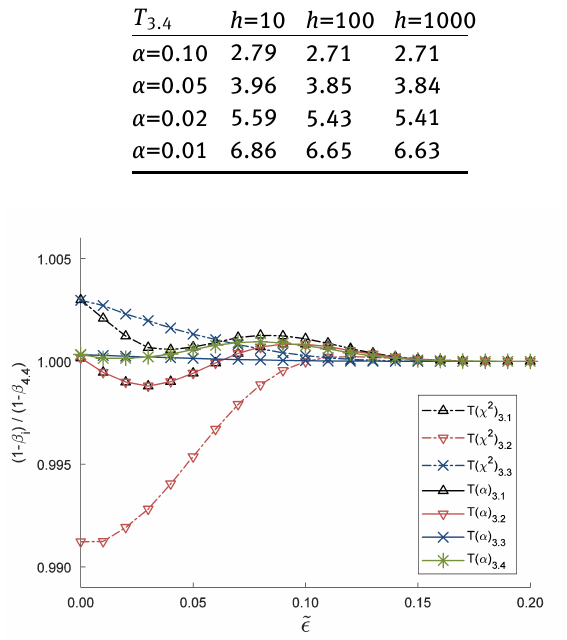
Table 2: Quantiles of the true distribution of T 3.4 | H 0